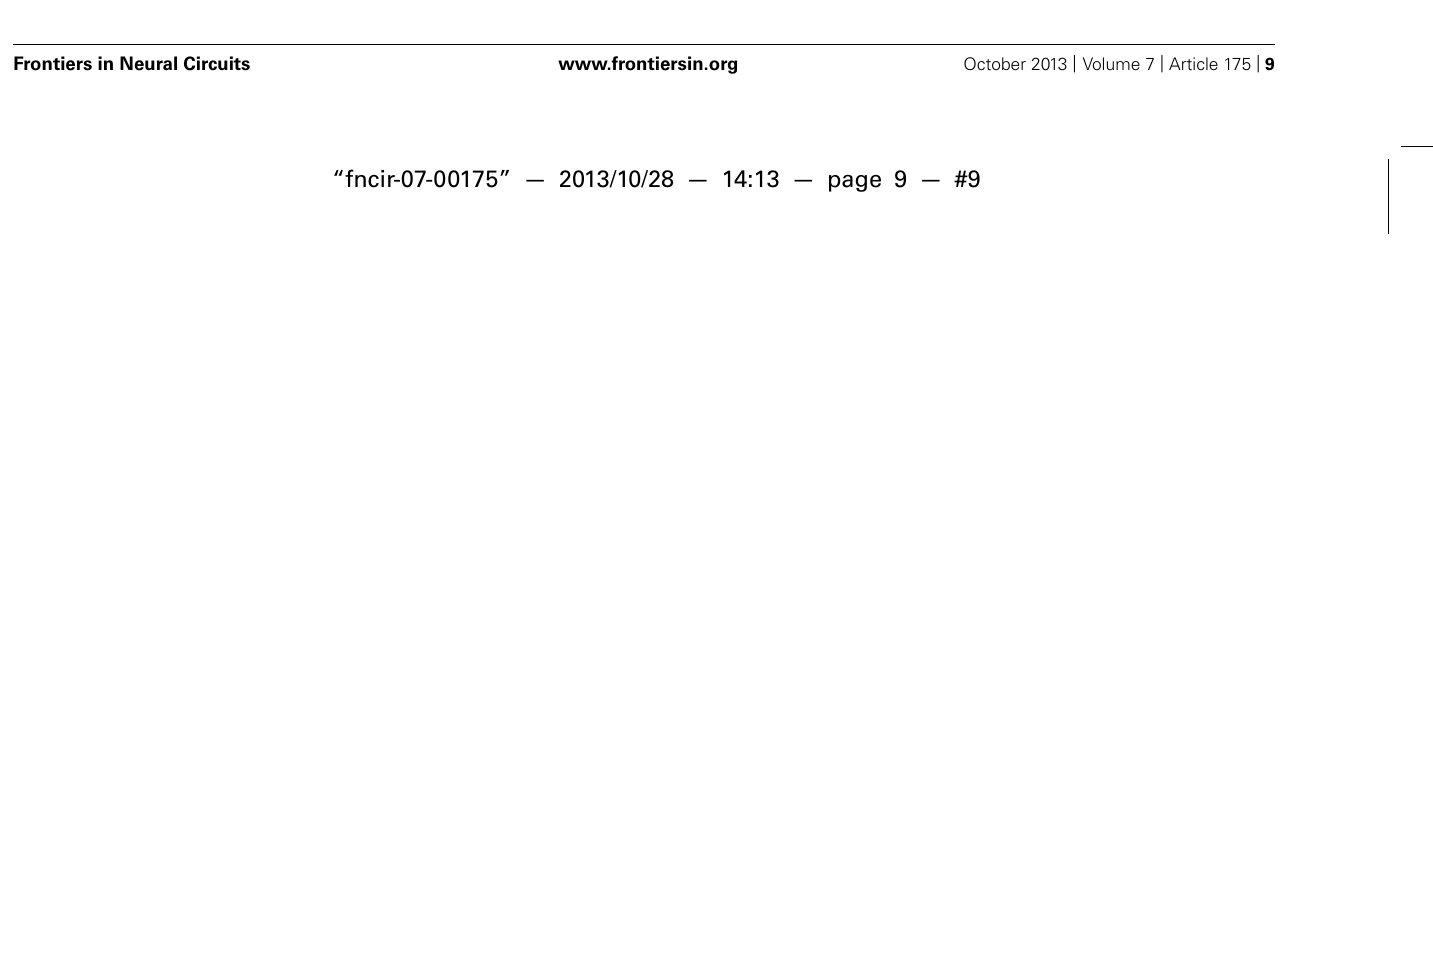
FIGURE 3 | Criteria for establishing a HiDi-insensitive response in slices as monosynaptic. (A) HiDi does not affect postsynaptic potentials (PSPs) evoked by minimal ( > 50% failure rate) LL stimulation. Left: PSPs from one cell. Shock strength: 0.1 ms, 0.2 mA. Middle: PSP durations and peak amplitudes, 42 cells. Mean and SD. PSP duration: t 83 = 0.71; p = 0.48; PSP amplitude: t 83 = 0.48; p = 0.63. Right: the lack of variability in onset latency between trials confirmed a monosynaptic source. Distribution of onset latencies measured from the stimulus artifact, 60 neurons. Onset latencies were within a ∼ 1 ms range (1.01–1.97 ms; mean 1.48 ms; SD 0.28). Because the SD of this distribution was < 1 (0.28 ms), responses were considered monosynaptic if their onset latencies during repeated trials did not vary by > 1 ms. (B) HiDi has no significant effect on PSPs evoked by a stimulus train at minimal shock strengths. Left: superimposed responses to repeated trials